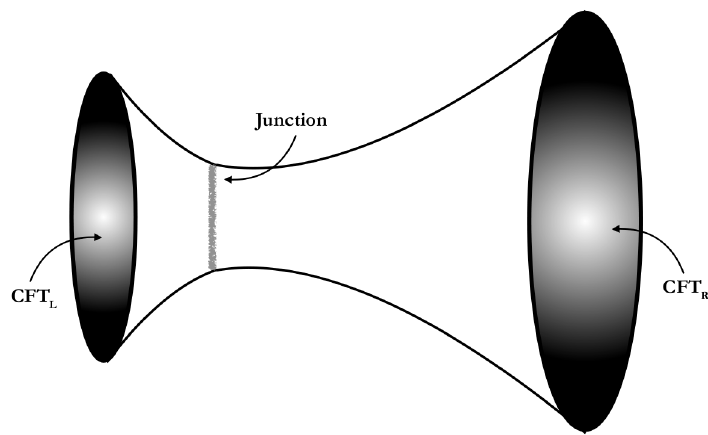
Figure 52 . The two-parameter pure gravity solution is obtained by gluing two halves of two different solutions across a junction at fixed u , in such a way that the metric and the extrinsic curvature are smooth. This way one can freely choose both length scales on each UV